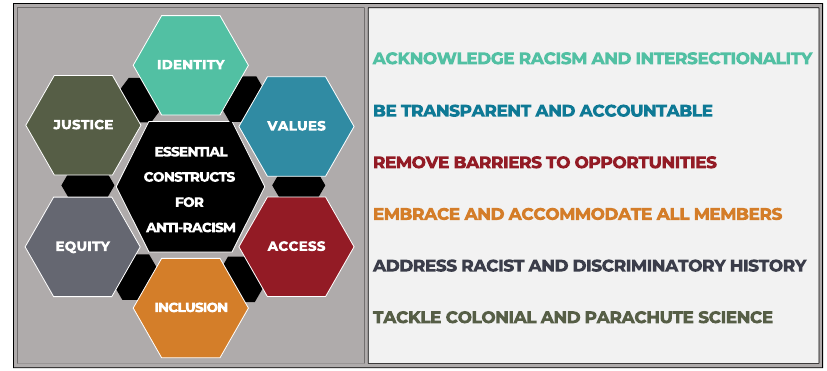
Fig. 1 Six essential constructs for